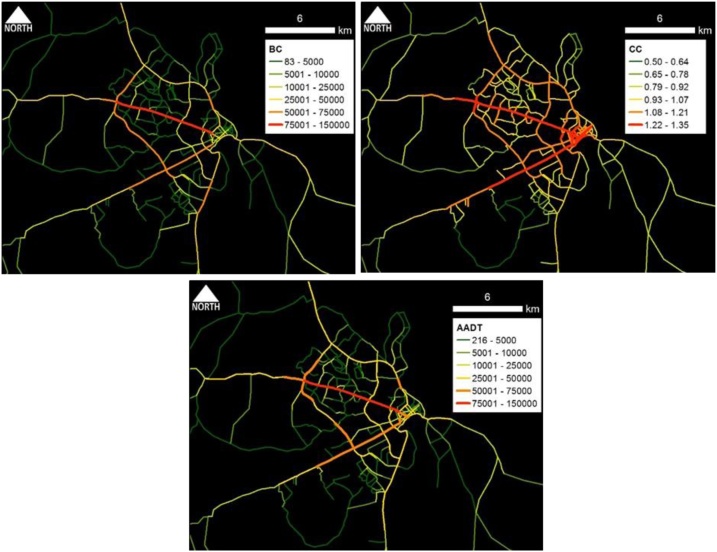
Dares Salaam case study area: Spatial distribution of (a) BC(PD) and (b) CC(PD) and (c) estimated AADT.